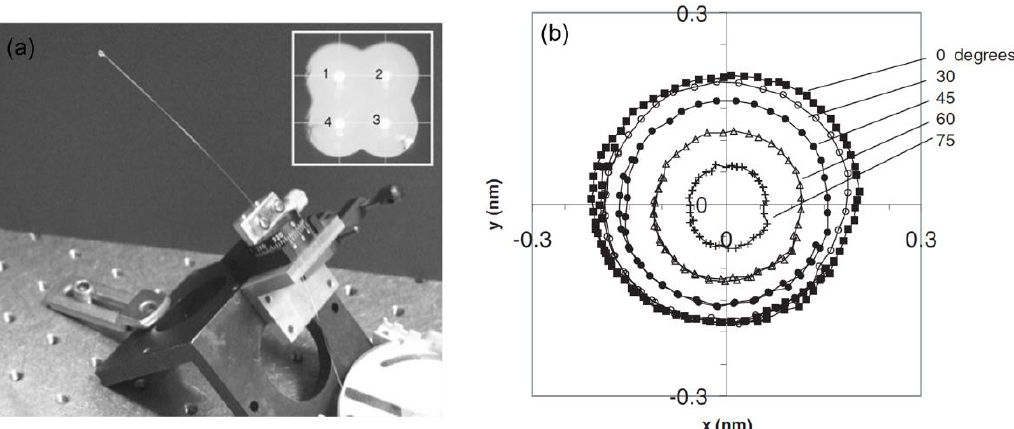
Figure 14. ( a ) Sensing fiber mounted in rotary stage; in this case the pitch angle is set at 45°. The inset shows the used four-core fiber in this experiment; ( b ) experimental results from pitch (θ) and roll (φ) measurements. x = λ1 − λ2, y = λ2 − λ3 are the diff erential Bragg wavelength shifts (in nm with offset removed) between orthogonal pairs (1, 2) and (2, 3) of MCF gratings. Data are plotted for θ = 0 °, 30°, 45° (φ range 0– 540° ) and θ = 60 °, 75° (φ range 0– 360°). Adapted with permission from Ref. [46].